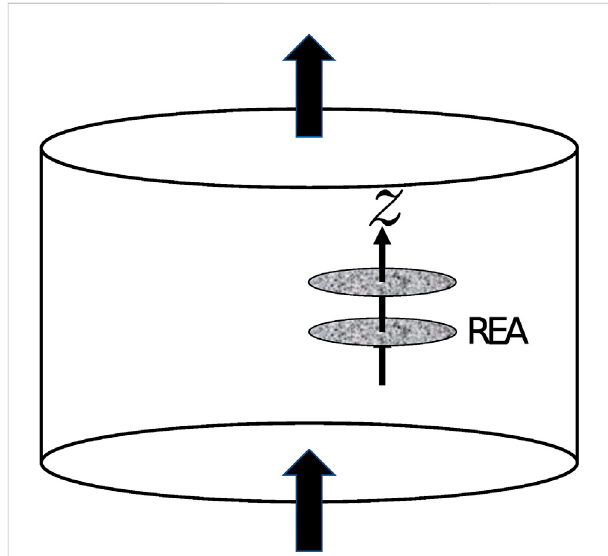
FIGURE 1 A porous plug in the form of a cylinder. There is a mixture of two immiscible fl uids fl owing through it inthedirectionofthecylinder axis under steady-state conditions. Two disks orthogonal to the cylinder axis are further imagined. These are